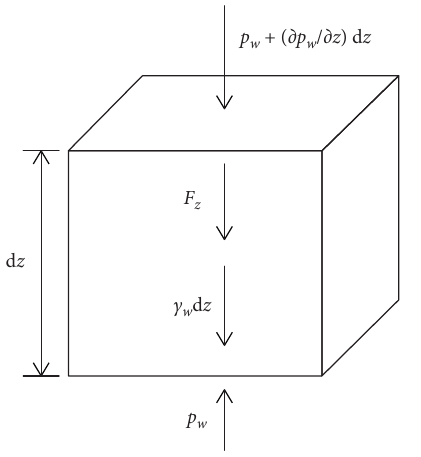
Figure 2: Unidirectional force diagram of the microunit with thickness of dz.